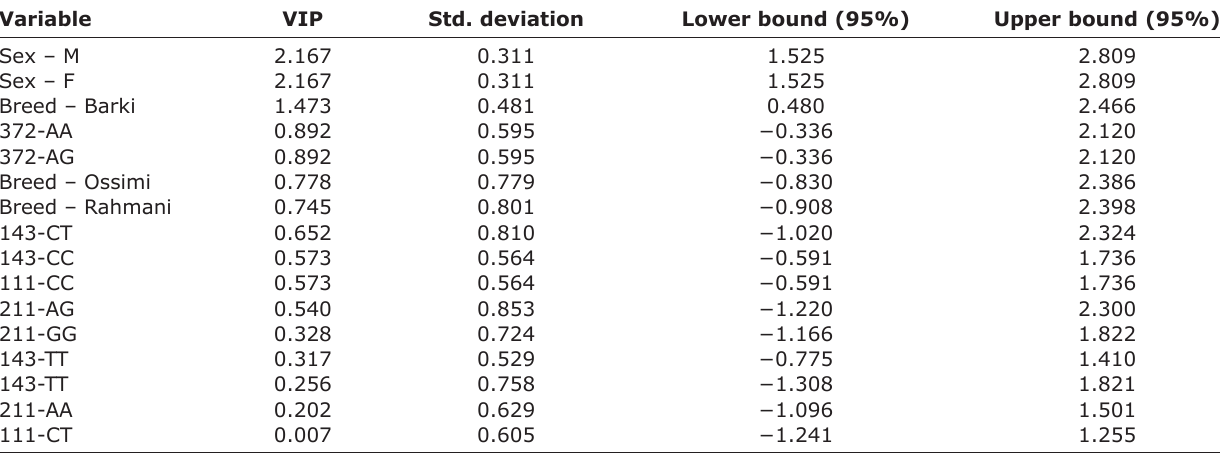
Table-5: Standardized coefficients of VIP for the traits studied (birth weight, BW; final weight at slaughter, FW; and average daily gain, ADG).